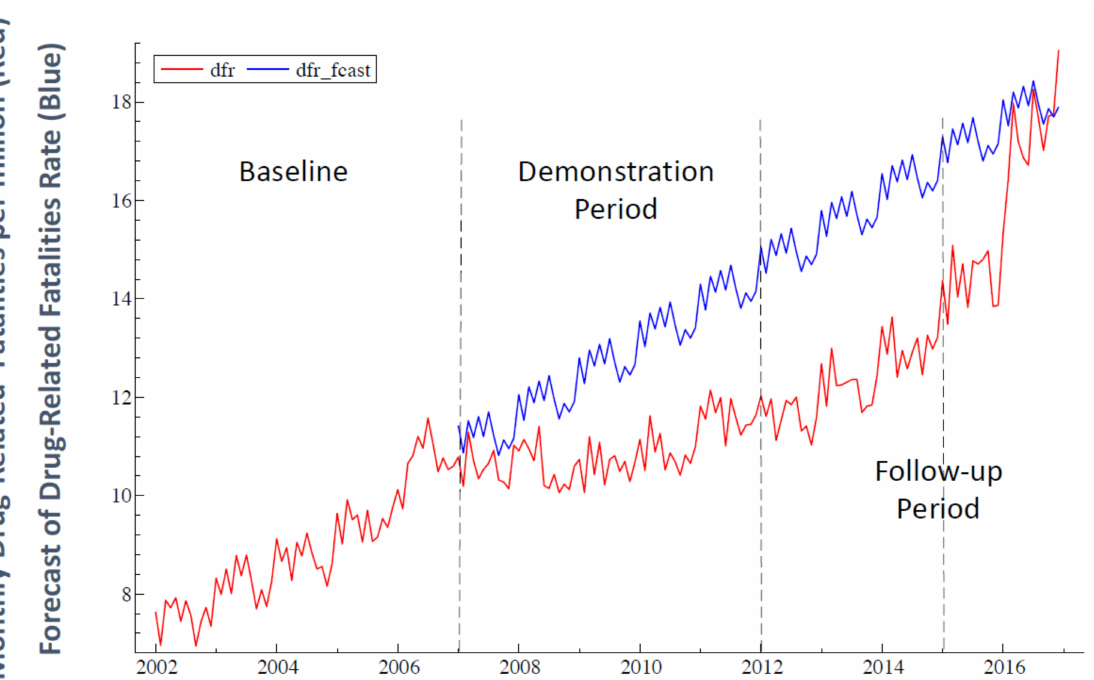
Figure 5. Time series plot of observed dfr (red) and the counterfactual forecast of future values of dfr (blue) for the demonstration and follow-up periods (January 2007–December 2016). The ex-ante, dynamic, one-step-ahead forecasts [98] are based on the baseline data